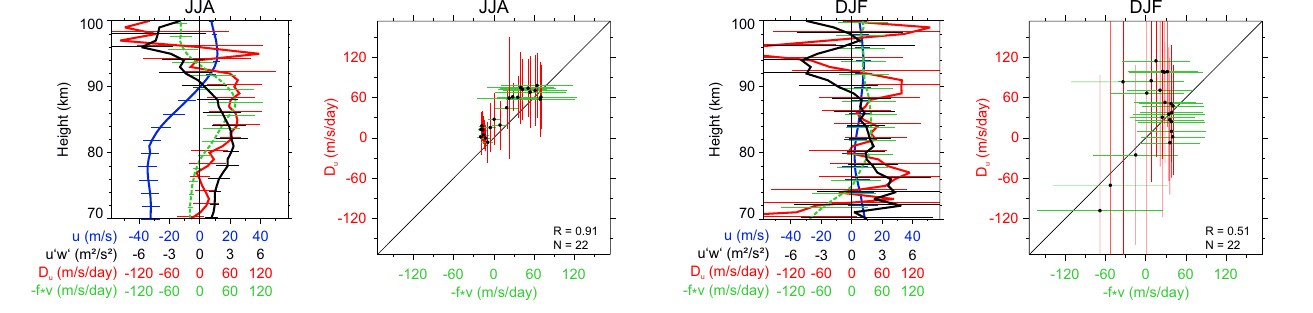
Figure 3. Same as Fig. 2, but for winter